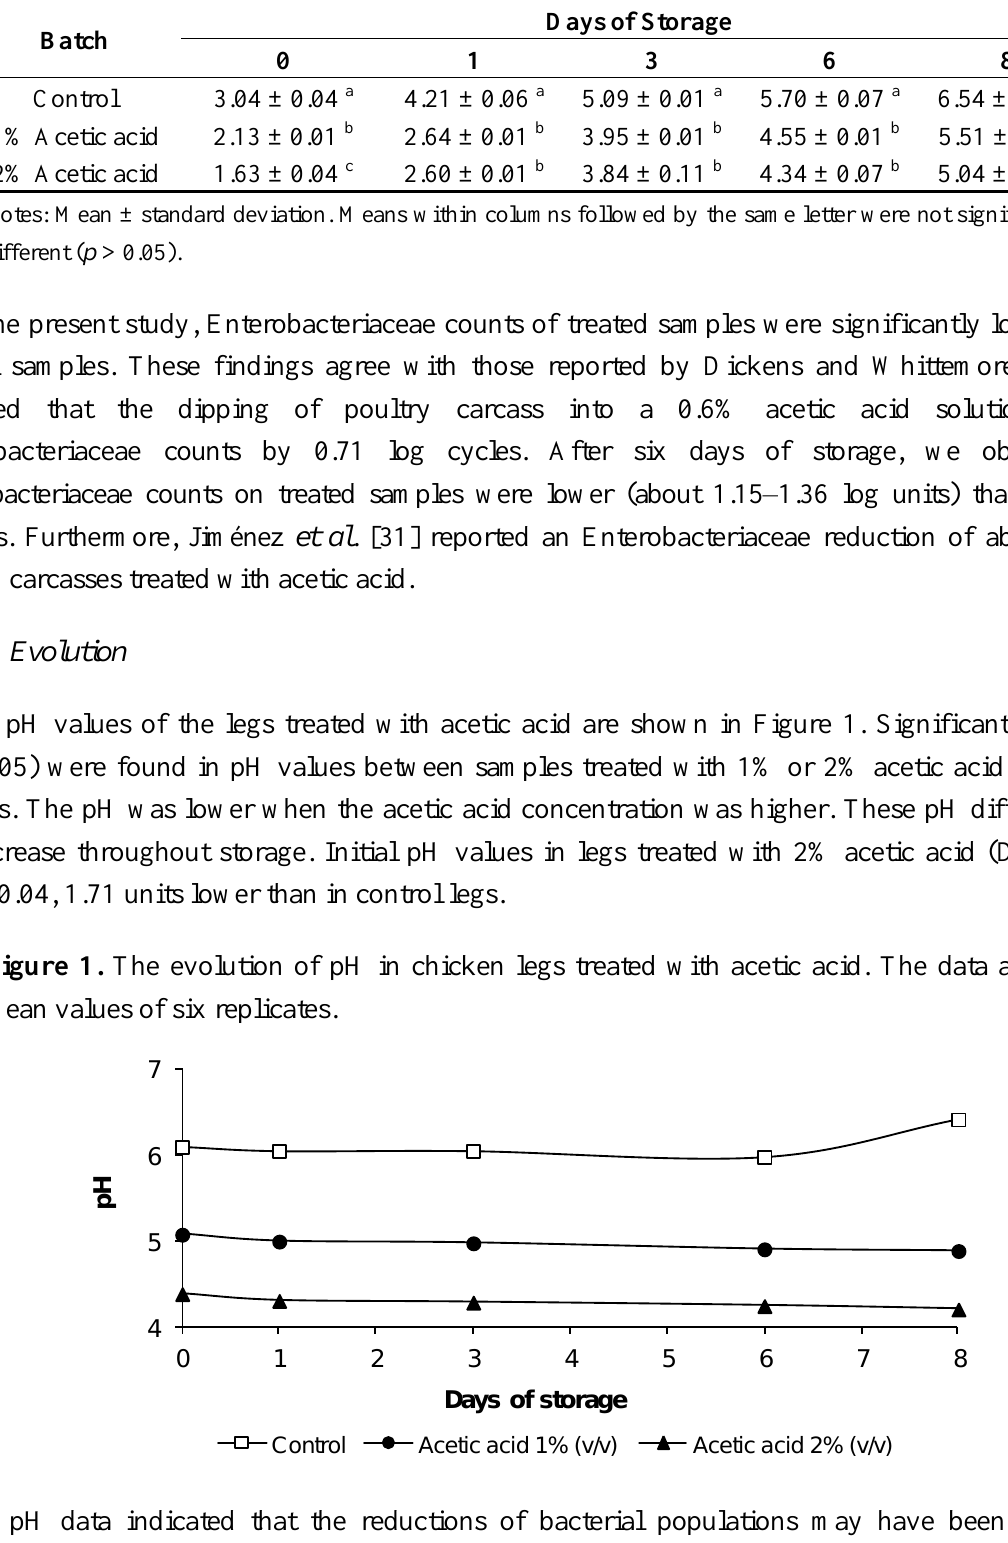
Table 3. The effect of acetic acid on the Enterobacteria counts on poultry legs (log CFU/g). Batch